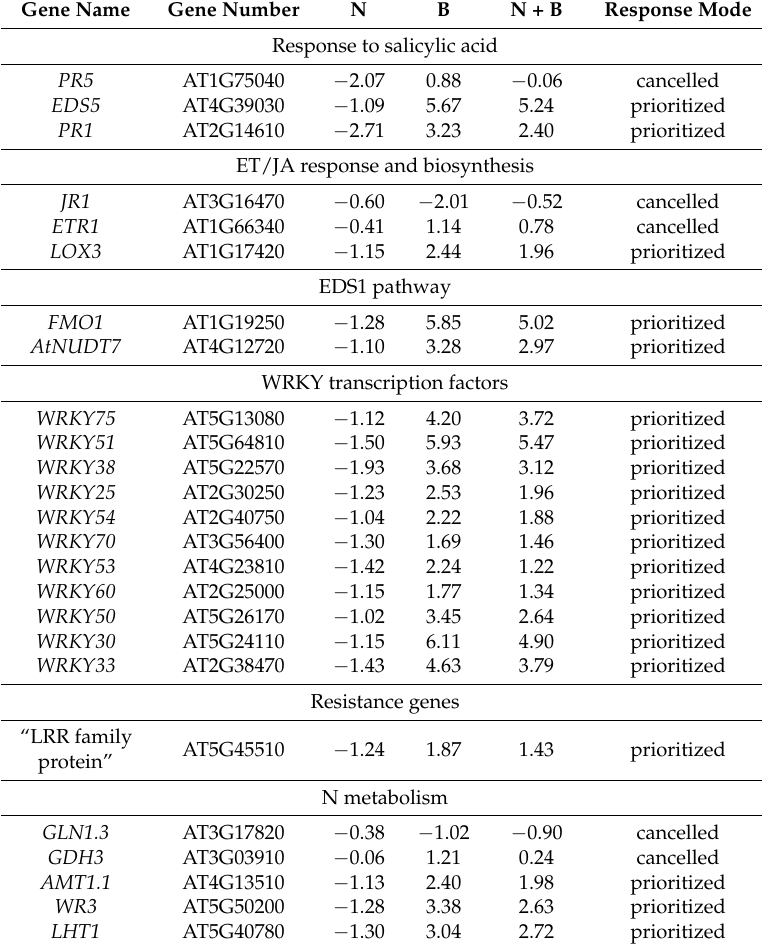
Table 2. Expression profiles of selected genes in response to single and combined stresses. Nondeducible gene profiles of selected defense-associated genes and N metabolism are presented. Values represent log2 signal ratios of the fold-changes upon single stresses (N:N limitation; B: Ea infection) or combined stresses (N + B:N limitation and Ea infection). The column at right indicates the transcriptional response mode according to the categories described by Rasmussen et al. 2013. N:N limitation, B: Bacteria, N + B: Combined stresses (N limitation and